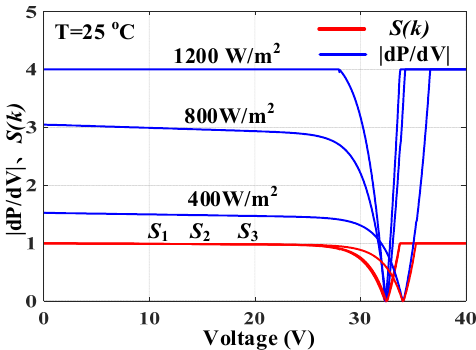
Figure 9. Characteristic curves of |dP/dV| and S ( k ).